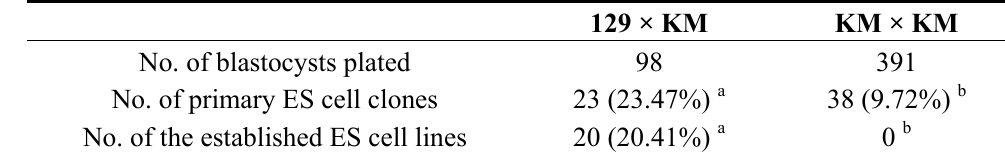
Table 4. Comparison of ES cell establishment from hybrid embryos of Kunming and 129 mice and Kunming mouse inbred